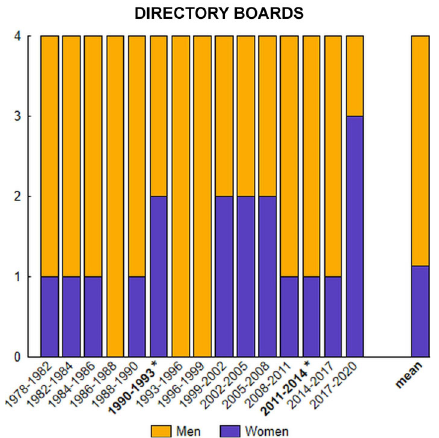
Figure 3. The percentage of women chairing symposia